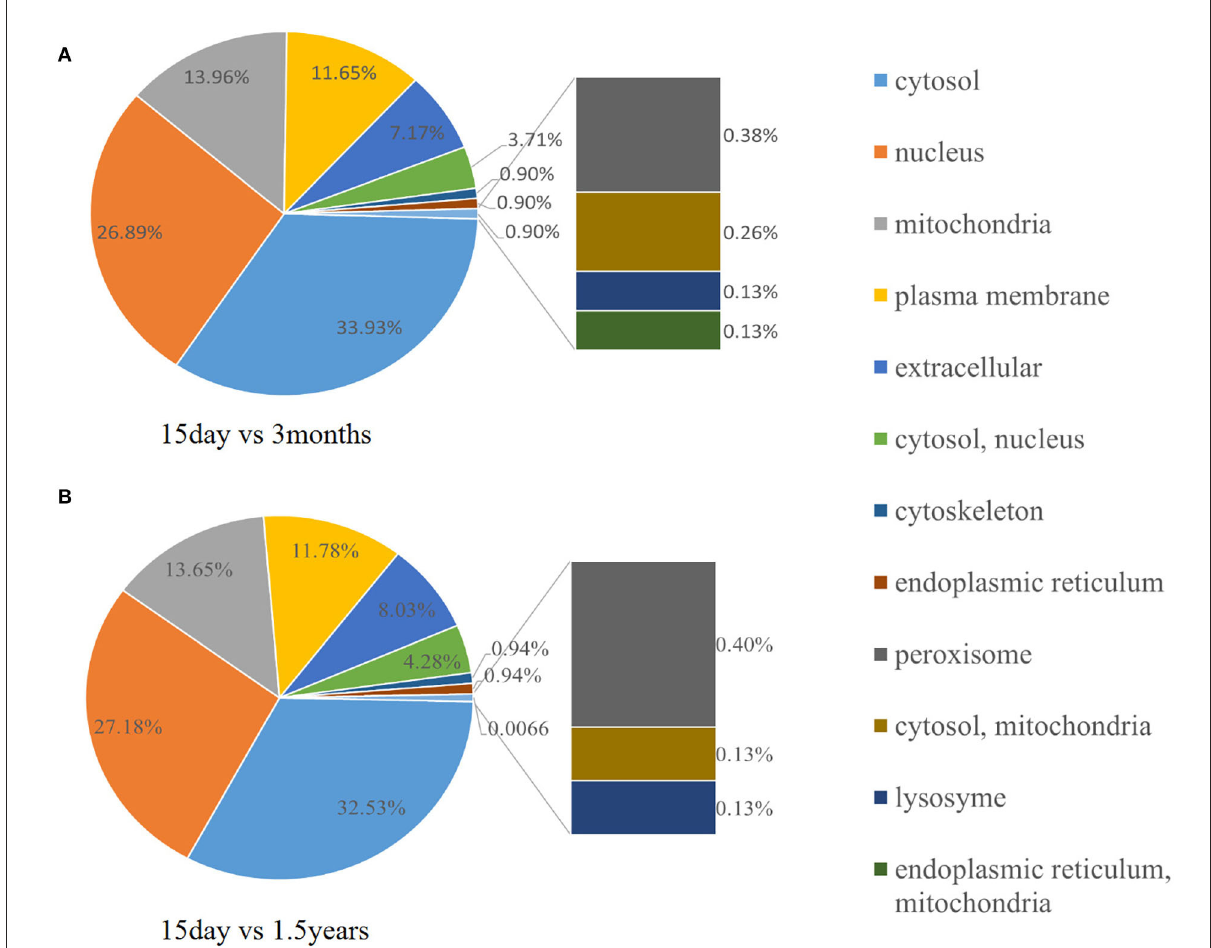
FIGURE8 Subcellular distribution of different proteins. The pie chart shows the subcellular distribution of differentially expressed proteins. The fan area represents the percentage of the subcellular distribution in the total amount of differentially expressed proteins. The larger the fan area, the higher the percentage. (A) The distribution of different protein subcells in the 15-day and 1.5-year age groups. (B) The distribution of different protein subcells in the 15-day and 3-month age